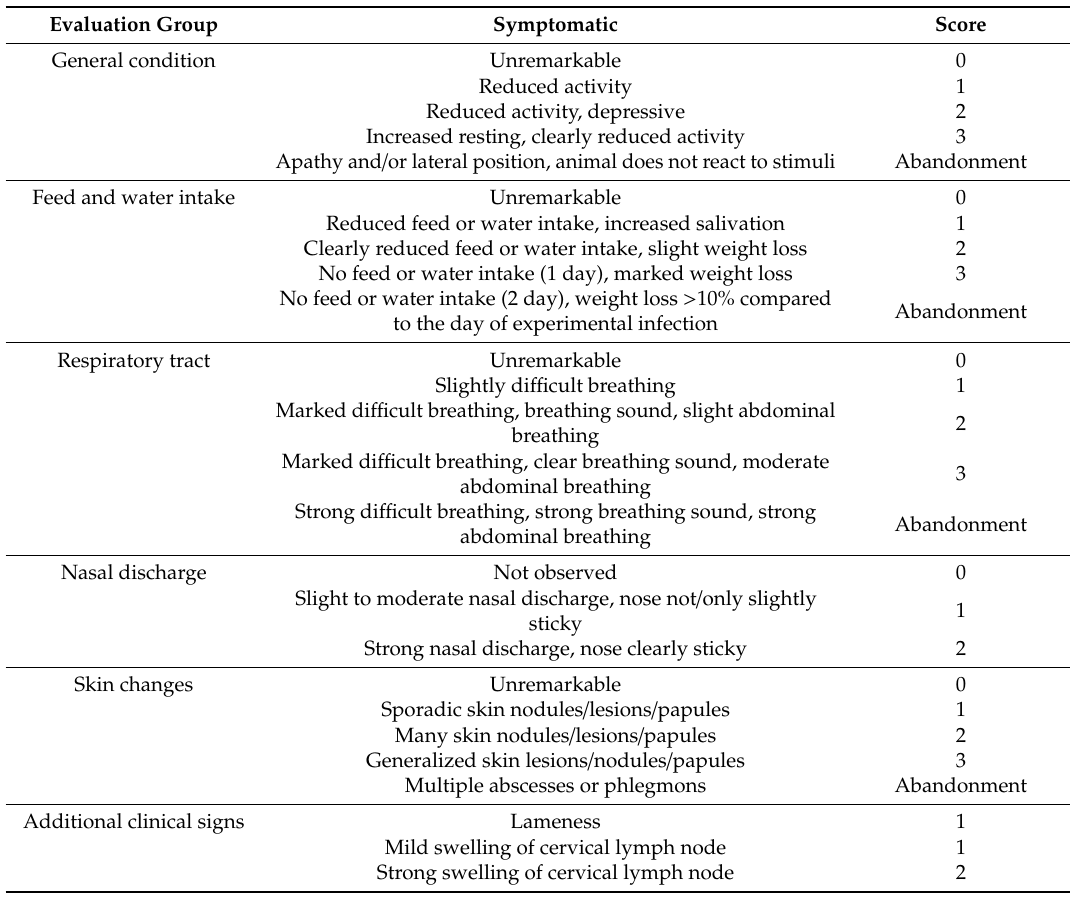
Table 3. Modified clinical score system for examination and categorization of SPPV infections in sheep. Evaluation